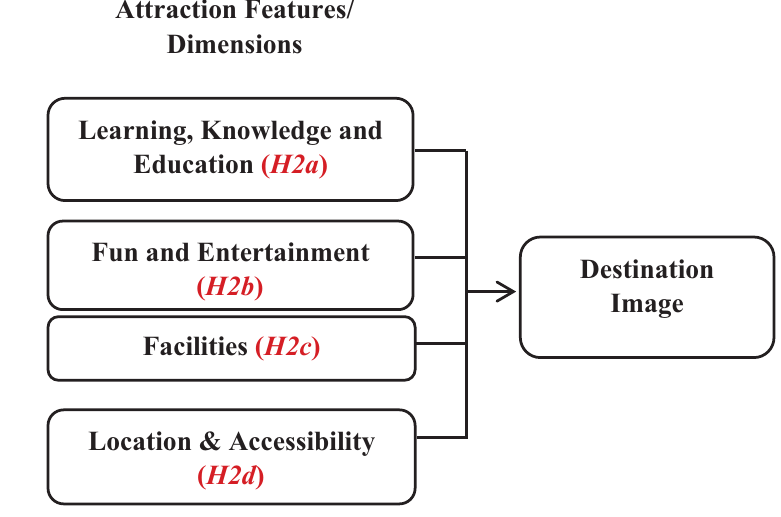
Figure 1. Conceptual model of the